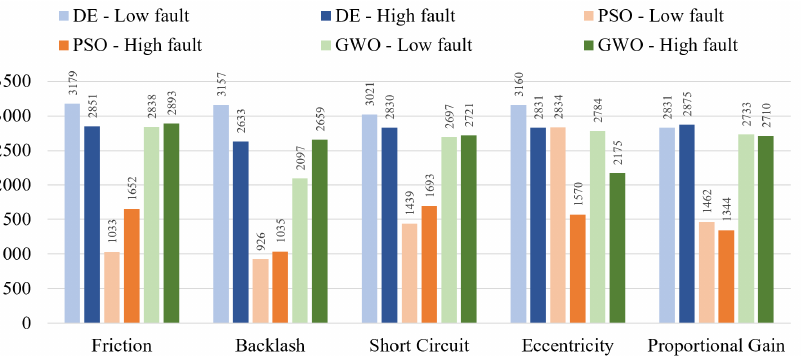
Figure 7. Comparison between different algorithms: mean percentage error [%]. For each failure mode and for each algorithm, the failure magnitudes are selected as follows: high magnitude ( k i = 0.75) and low one ( k i = 0.25).